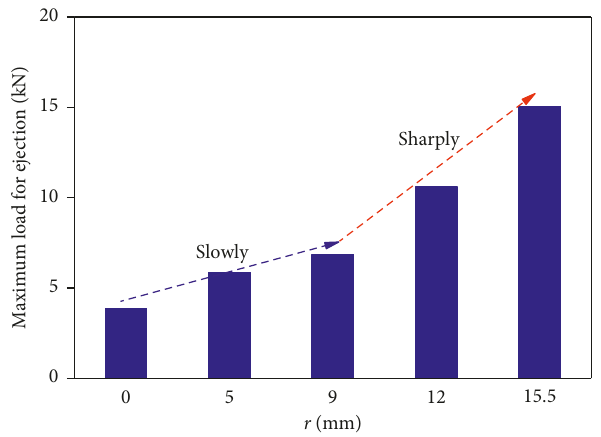
Figure 6: Maximum load for ejection on manufacturing hollow- structured